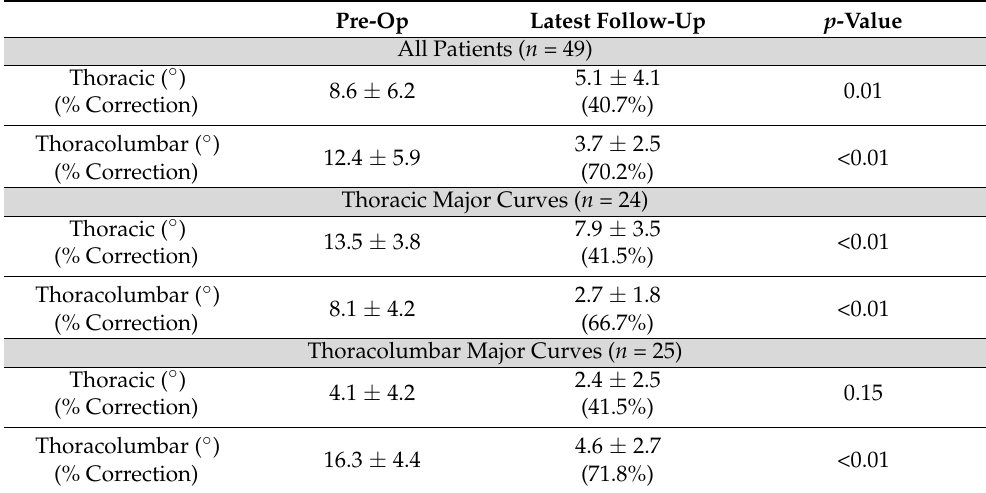
Table 3. Inclinometer